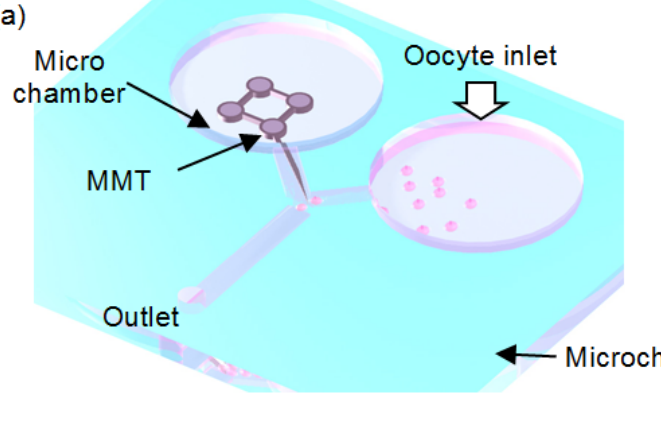
Figure 1. ( a ) Overview of the enucleation microchip. ( b – e ) Concept of the oocyte enucleation process by the use of magnetically driven microtools (MMTs) in a micro fl uidic chip. Blue arrows show the flow direction. ( f ) Height differences in the microchannel design. The white arrow shows the movement of the